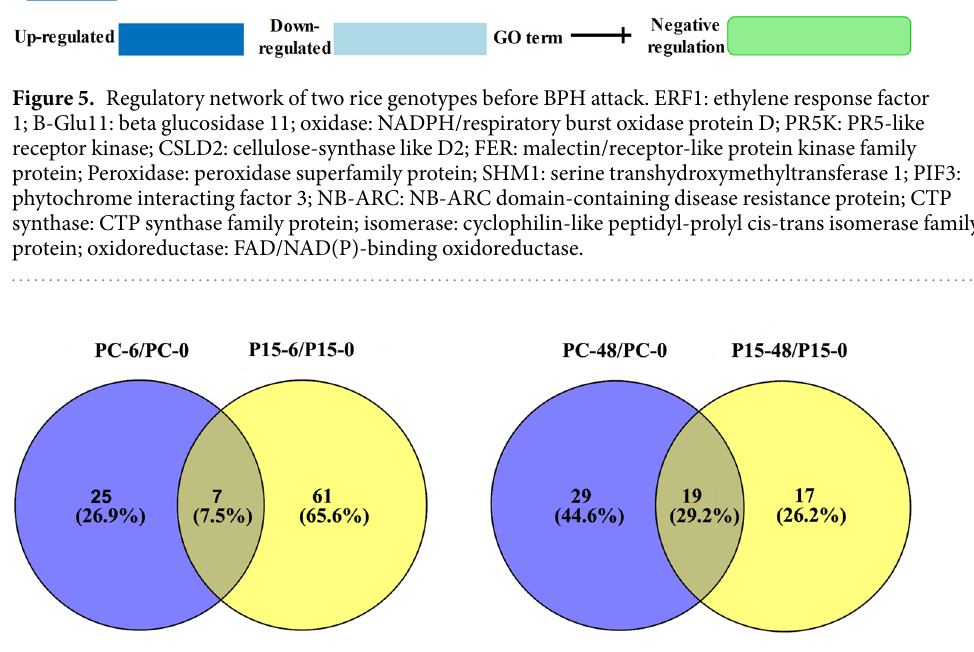
Figure 6. Venn diagrams of differentially expressed miRNA candidates. Venn diagram of the number of differently expressed miRNA molecules of the resistant BPH15 introgression line (P15) and susceptible recipient line (PC) at 0 h, 6 h and 48 h after BPH